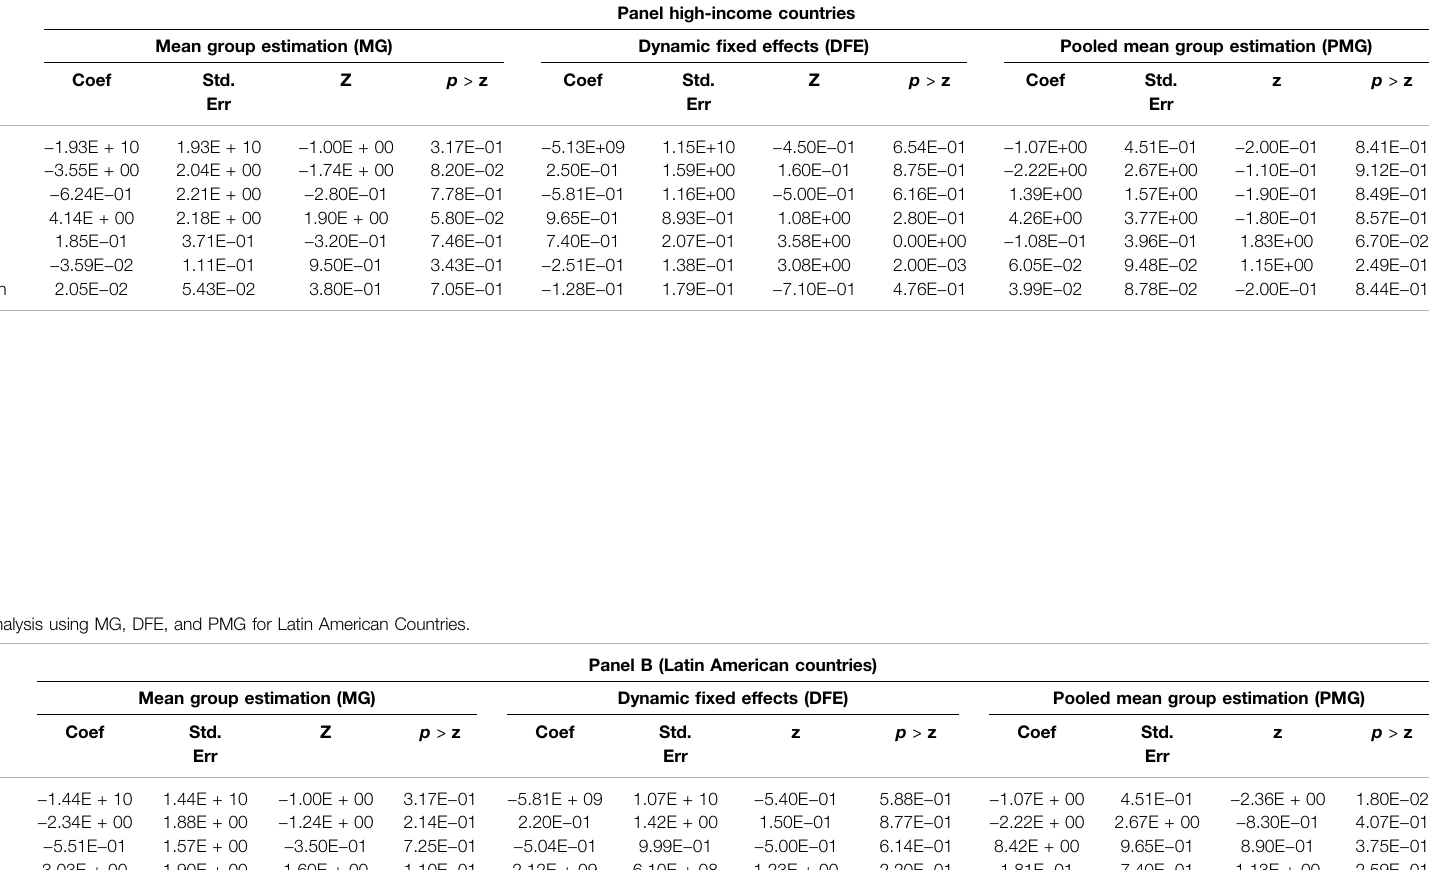
TABLE 4 | Panel Data Analysis using MG, DFE, and PMG for high-income Countries.